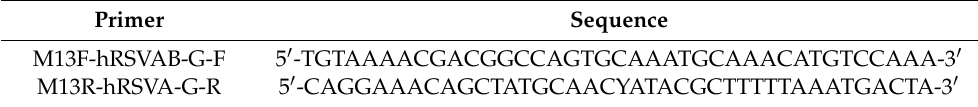
Table 1. Primers used for amplification of the RSV-A G